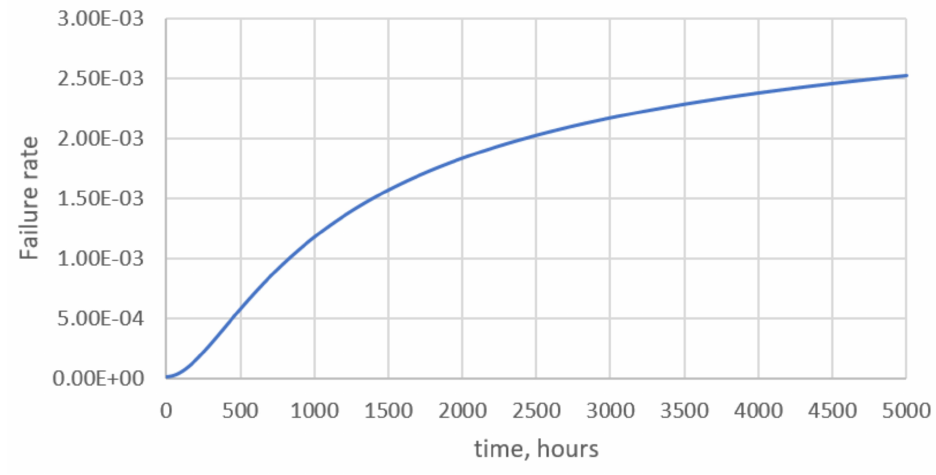
Figure 6. The failure rate of the hierarchical ramified system in the availability condition k =